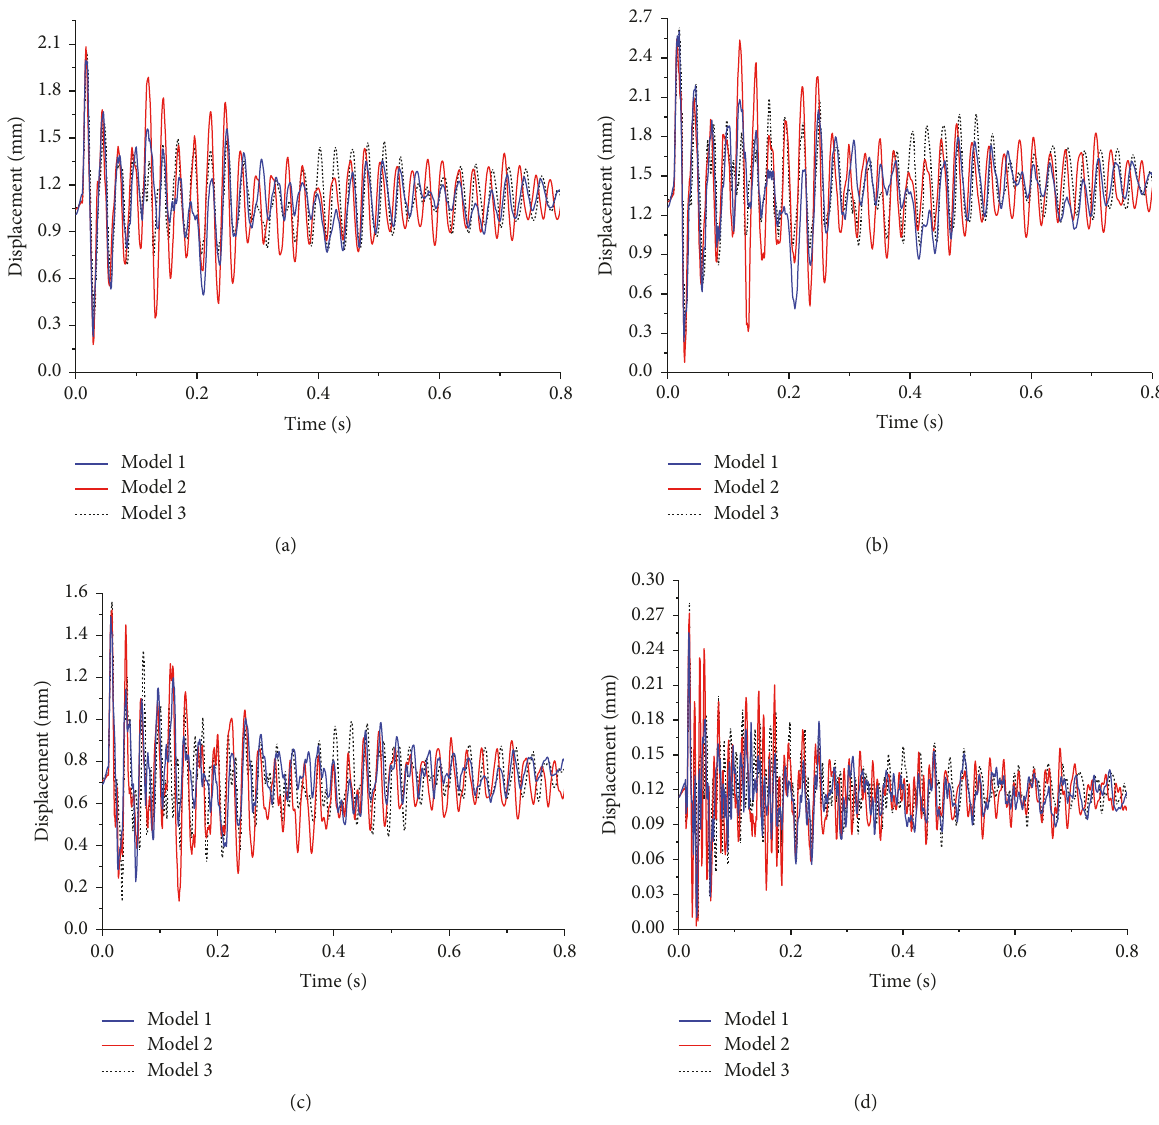
Figure 11: Displacement time history curve of nodes: (a) node 1, (b) node 2, (c) node 3, and (d) node 4.